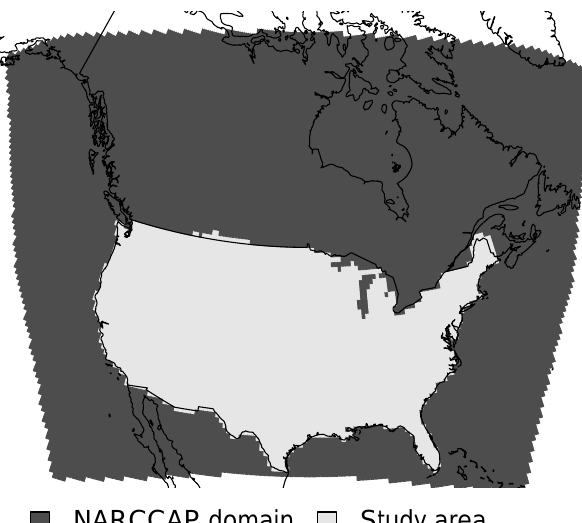
Figure 1. The shading (dark and light) indicates the NARCCAP study area. The light shading indicates the continental United States locations analyzed in Sect. 4. The black lines indicate relevant na- tional